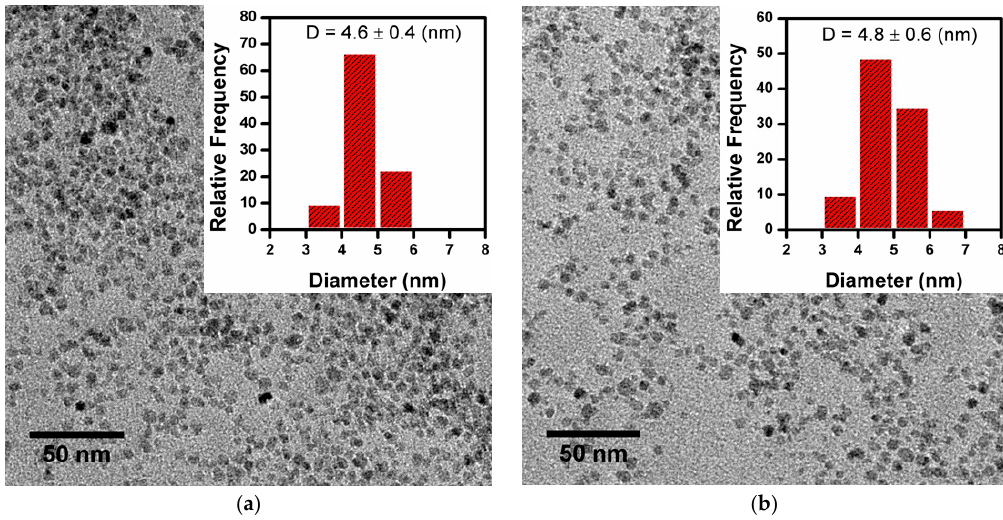
Figure 3. TEM image and histogram (insert) of MIONs prepared with: ( a ) 0.768 mM PTMP-PMAA; and ( b ) 0.072 mM PTMP-PMAA.